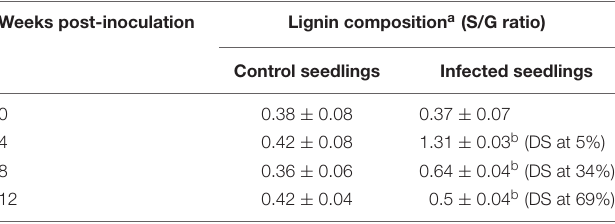
TABLE 2 | Lignin composition measured as syringyl to guaiacyl (S/G) ratio in oil palm root tissues; control seedlings (non-inoculated) and infected seedlings ( Ganoderma boninense